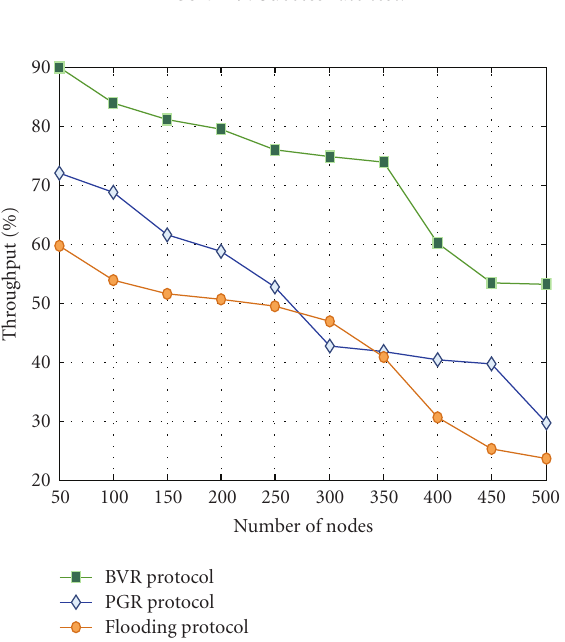
Figure 19: Success rate test.